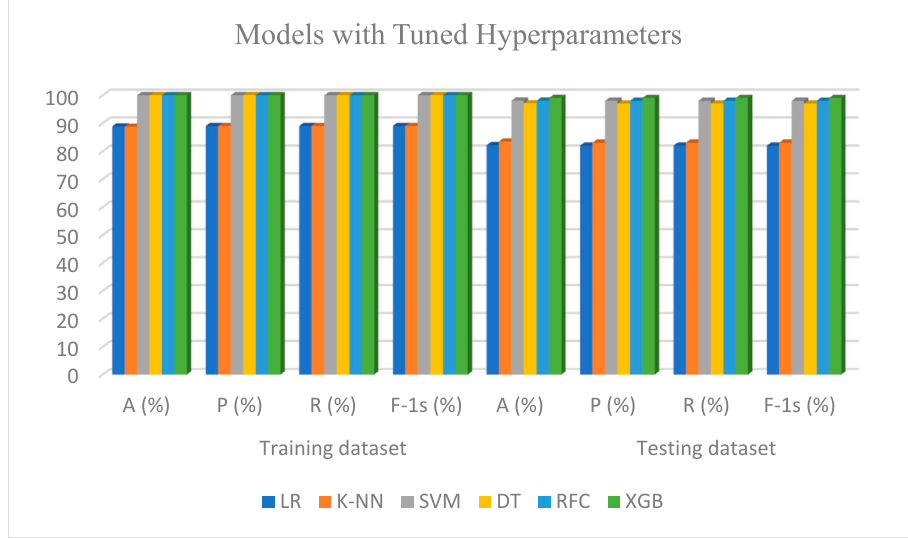
Figure 10. The bar plots comparing the accuracies of the training and testing datasets. Table 11. For the training set and the test set, classification report models were evaluated and compared using a hyperparameter tuning strategy.